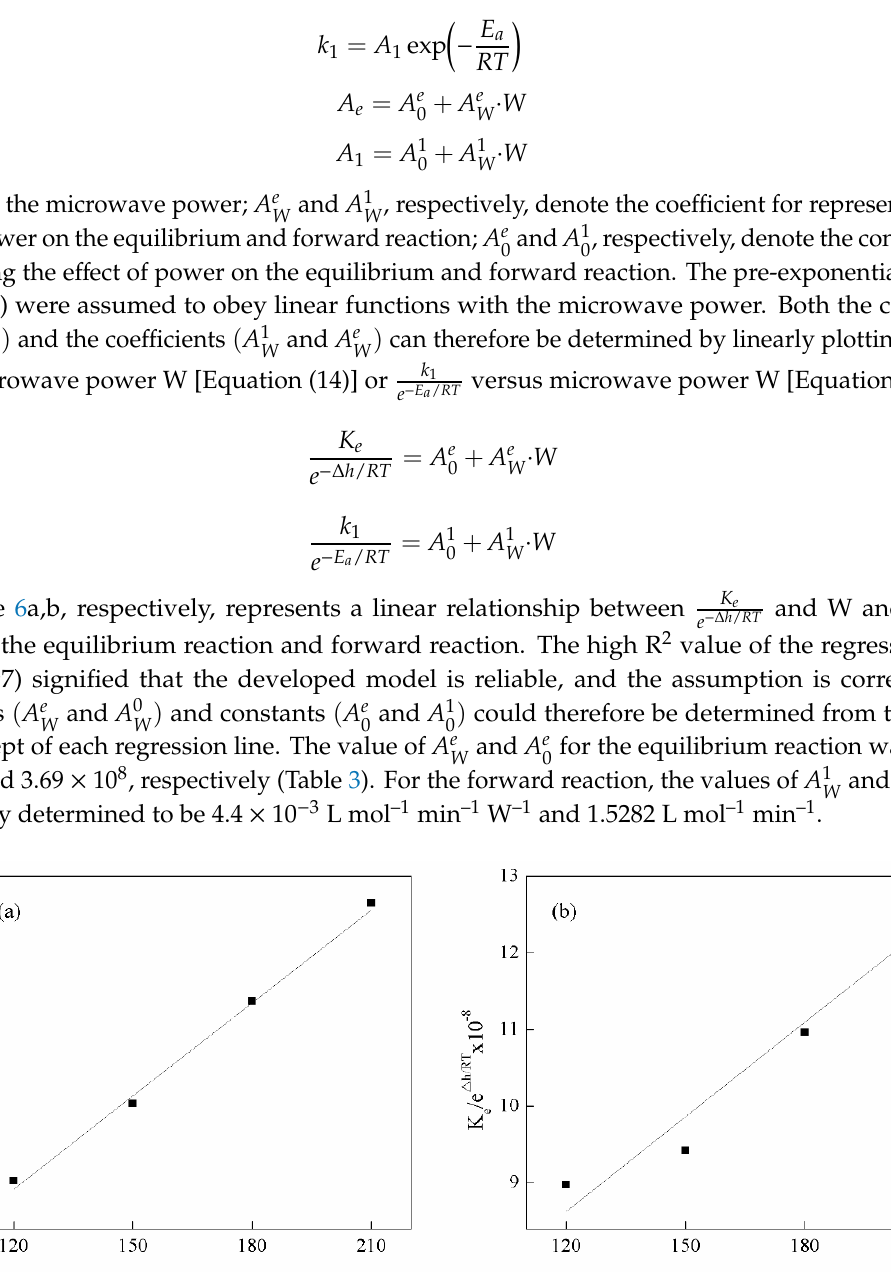
Figure 6. Linear regression of the experimental data for determining microwave power constants and coefficients for forward reaction ( a ) and equilibrium reaction ( b ).